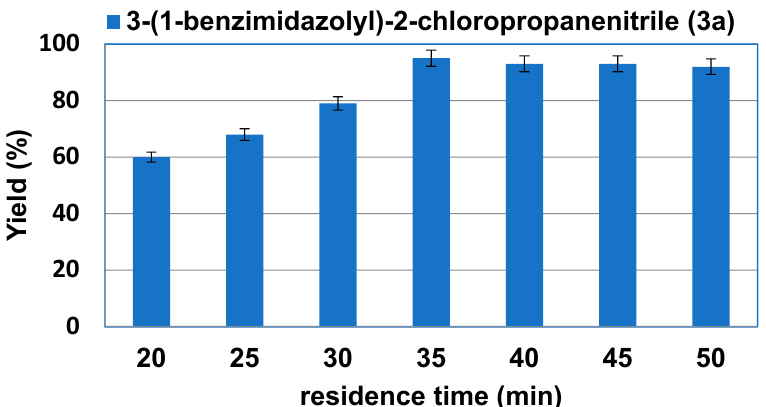
Figure 4. The influence of residence time on the synthesis of N-substituted benzimidazole derivatives catalyzed by lipase TL IM from Thermomyces lanuginosus in continuous-flow microreactors.